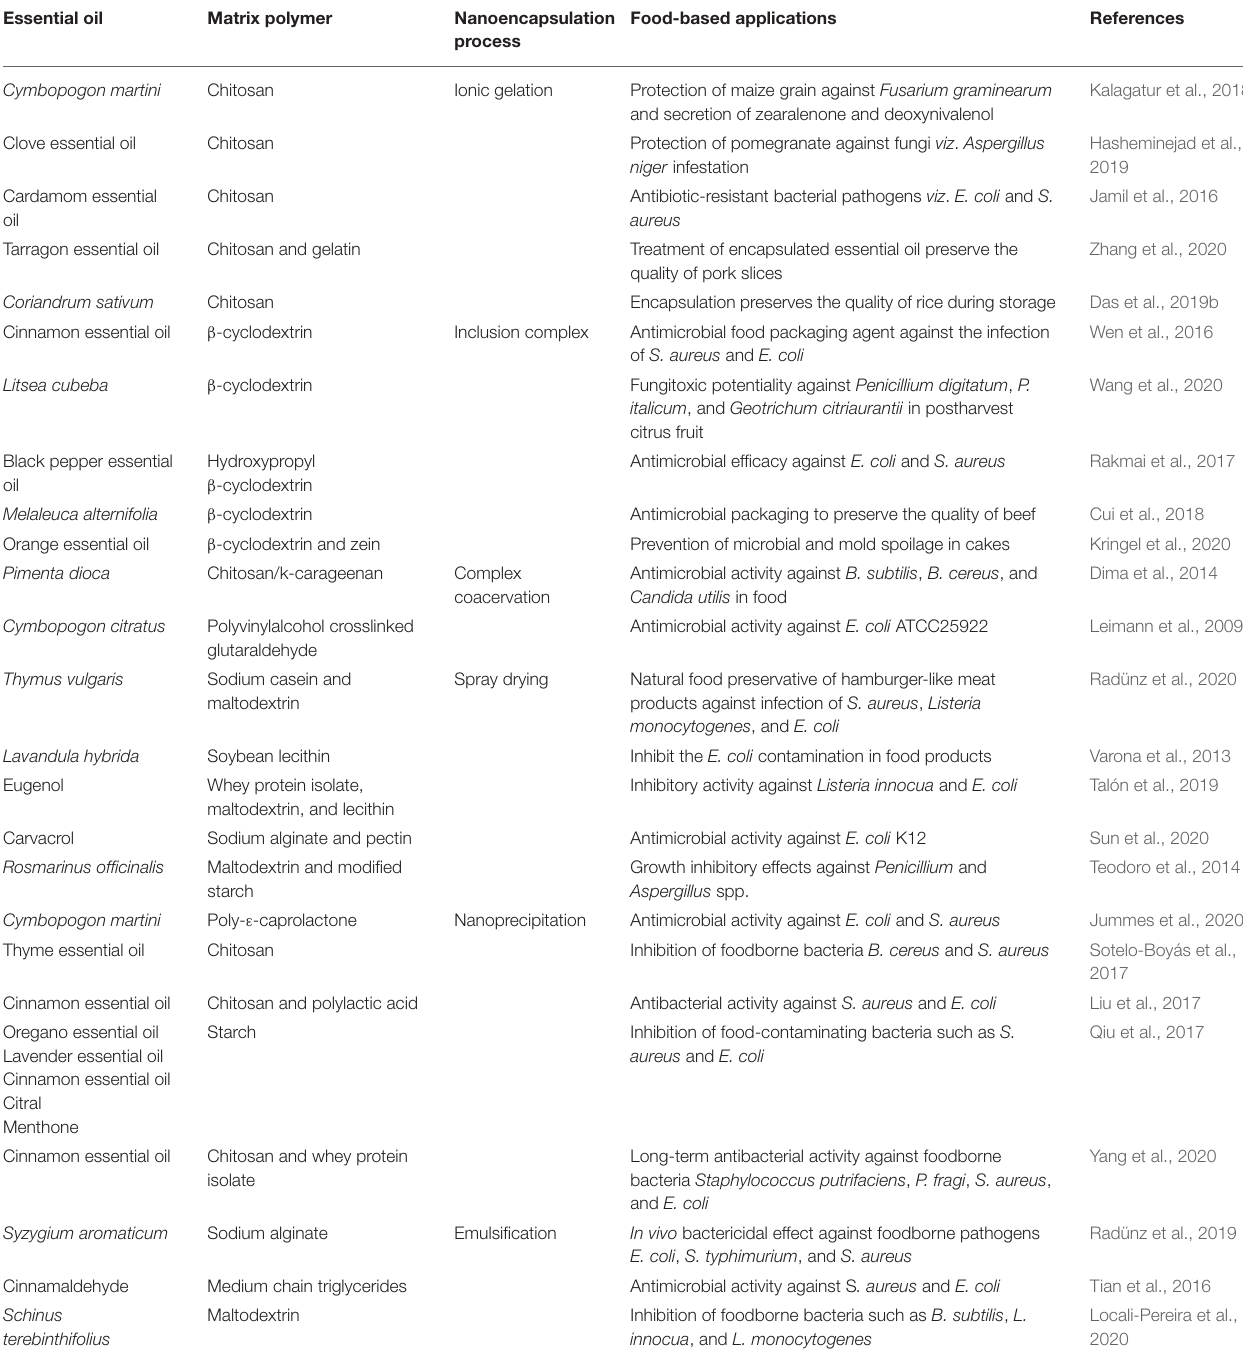
TABLE 4 | Nanoencapsulation of essential oil with special emphasis on food